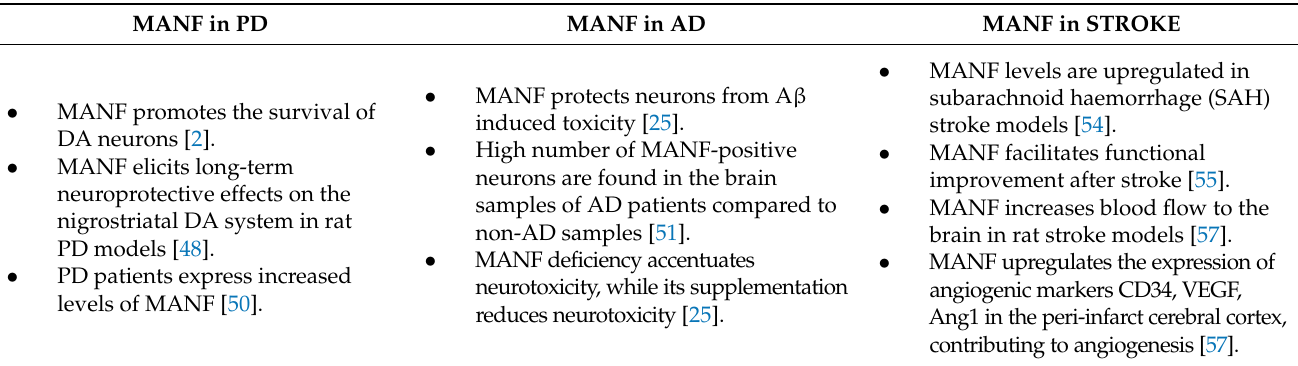
Table 1. Actions of MANF in PD, AD, and